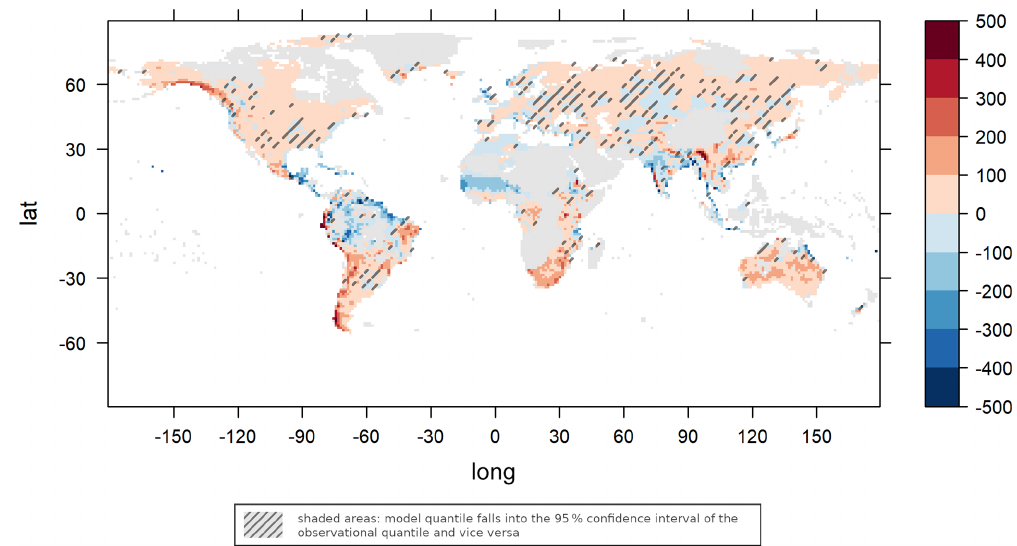
Figure 10. Difference in the 0 . 95 quantiles for the estimated GEV distribution from EC-Earth3-Veg-LR model and the observational data. Values exceeding the scale limits are truncated. Values are given in millimetres per month.